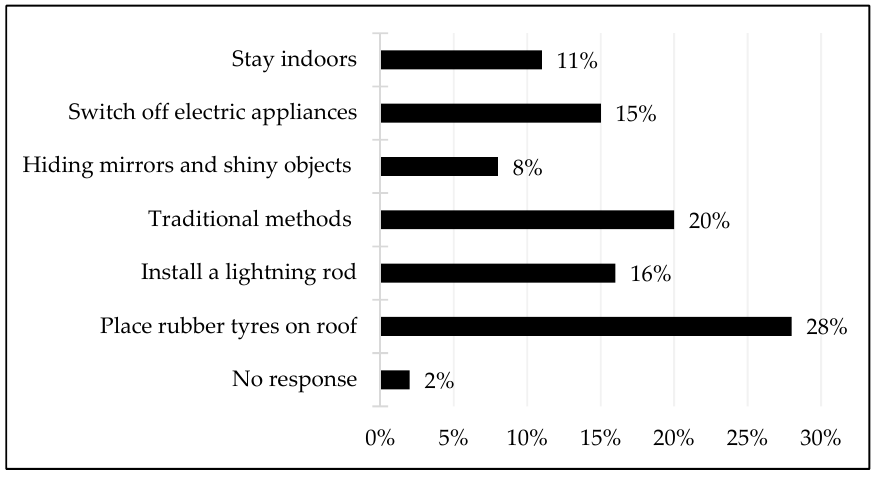
Figure 5. Lightning prevention strategies.